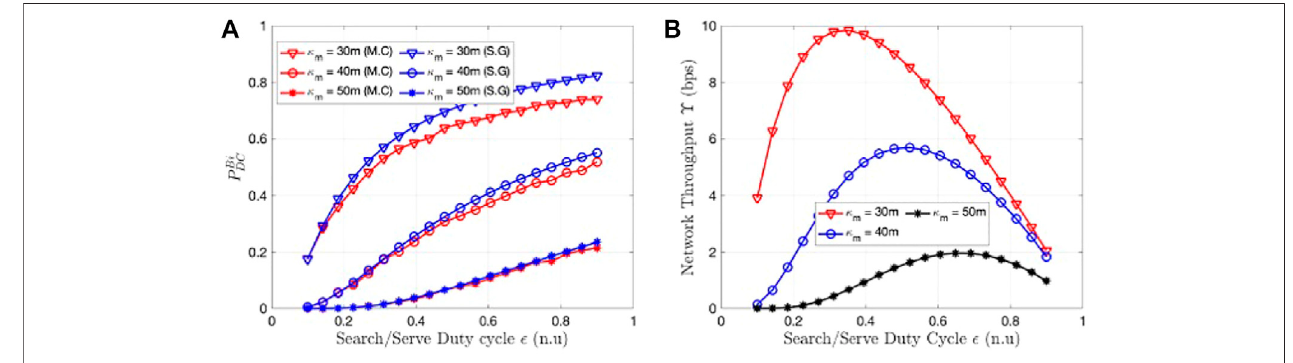
FIGURE 3 | (A) Detection coverage ( P Bi DC ) and (B) network throughput ( ϒ ) as a function of explore/exploit duty cycle ( ϵ ) for parametric bistatic range ( κ